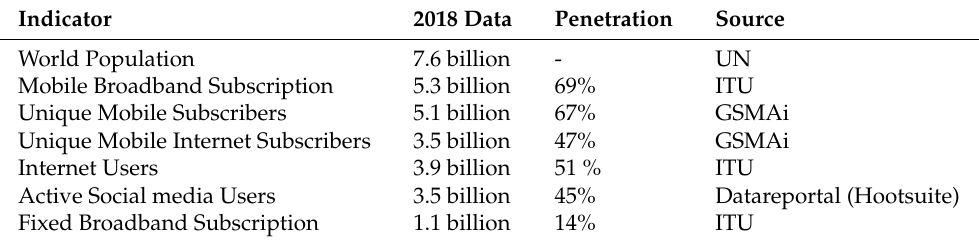
Table 1. Percentage of world population with communication as of